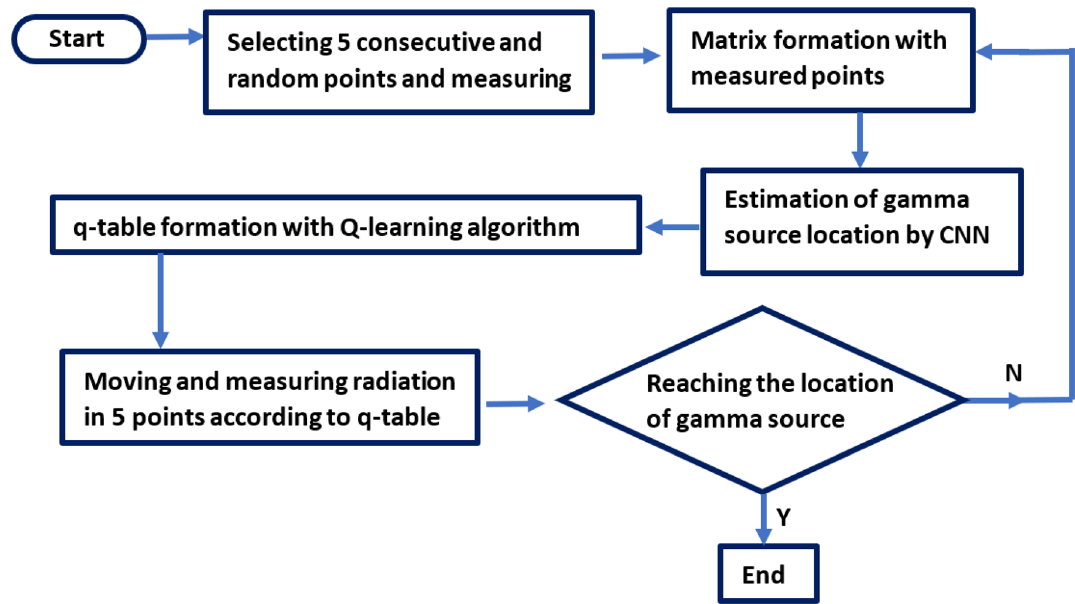
Figure 5. Diagram of the proposed algorithm using Q-learning and